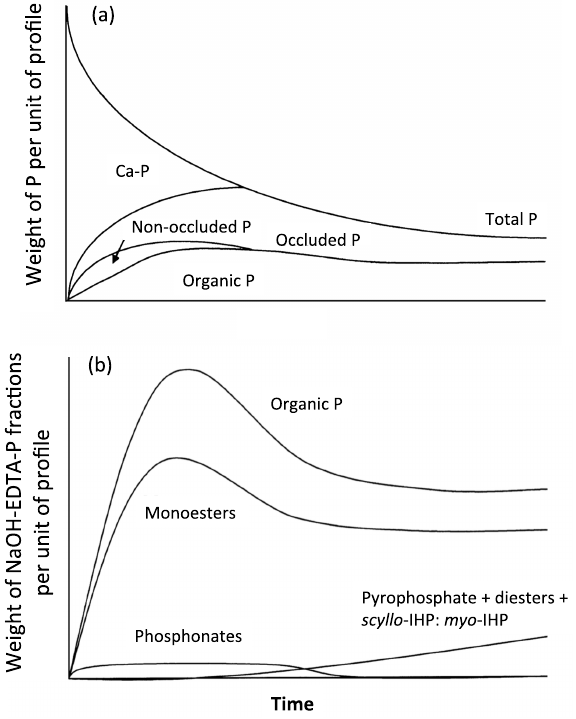
Figure 1. Conceptual diagrams of the changes in soil P fractions (a) and NaOH-EDTA extractable P compounds (excluding orthophos- phate) (b) with time (redrawn from Walker and Syers, 1976, with permission from Elsevier, and McDowell et al., 2007, with permis- sion from John Wiley and Sons,